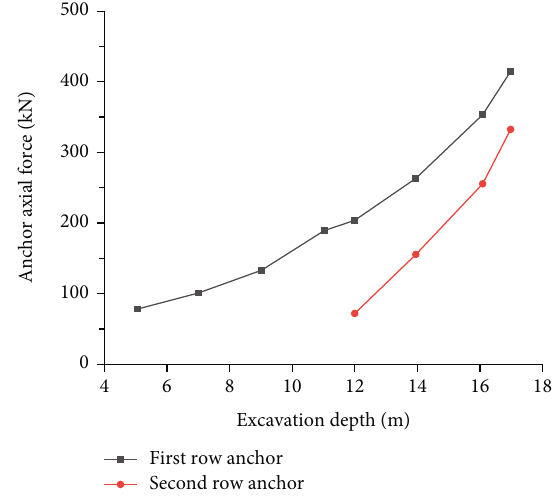
Figure 13: Variation curve of the axial force of the fi rst and second row anchors with the excavation depth.